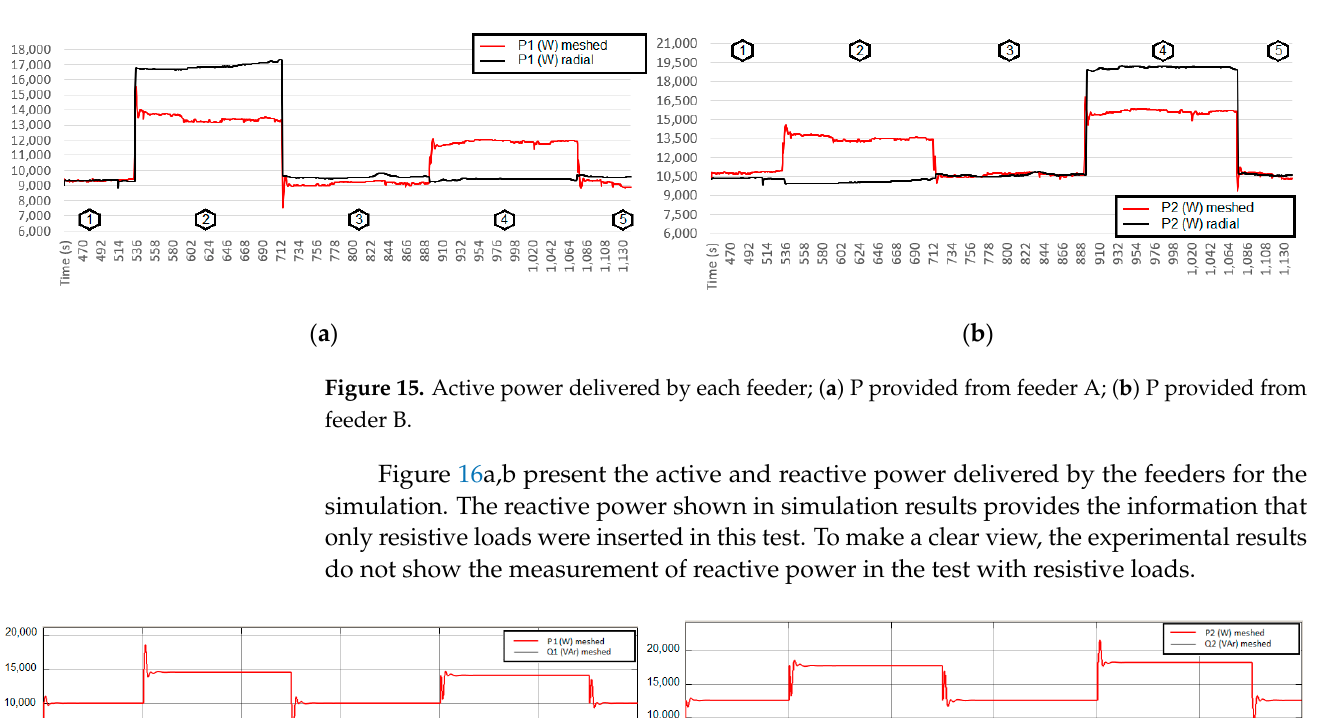
Figure 14. Phasors before and after power flow manipulation; ( a ) R 1 insertion stage–without the converter operation; ( b ) R 1 insertion stage–with the converter operation.